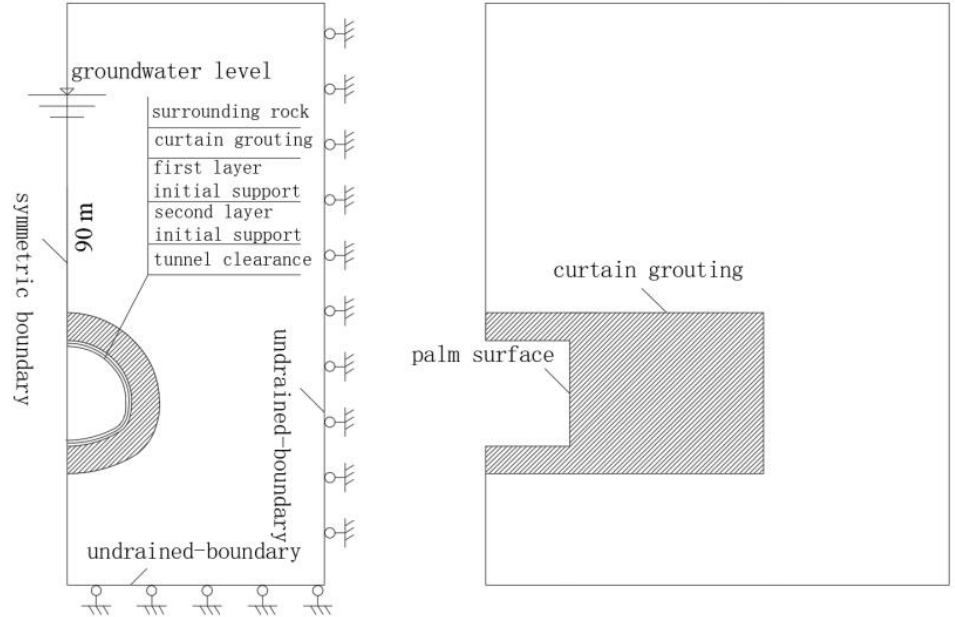
Figure 6. Sketch map for curtain grouting model boundary.